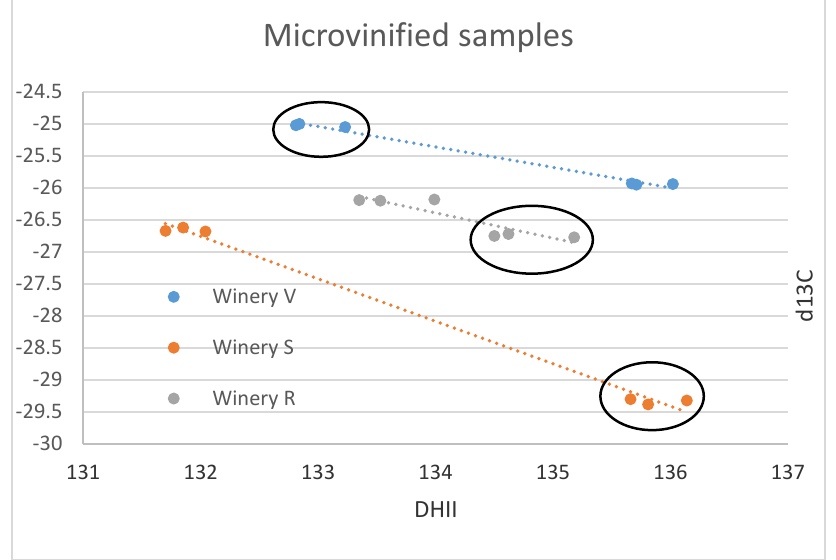
Figure 2. Individual wineries’ small-scale samples δ 13 C versus (D/H)II results in ‰ versus V-PDB for δ 13 C and in ppm for (D/H)II. The results of all three wineries investigated are negatively correlated. Ellipses identify the Sauvignon Blanc from the Chenin samples of the small-scale samples of the wineries R, S, V.